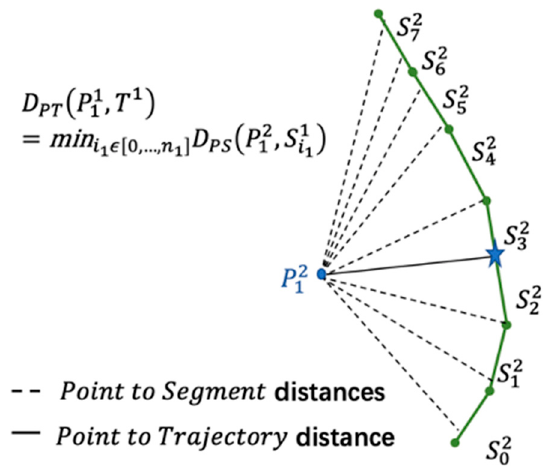
Figure 10. Distance from point 𝑝 (cid:2869)(cid:2870) to 𝑇 (cid:2869) . 𝑆 (cid:3036)(cid:2870) represents segments. The distance of 𝑃 (cid:2869)(cid:2870) between 𝑆 (cid:2871)(cid:2870) is the the minimum.